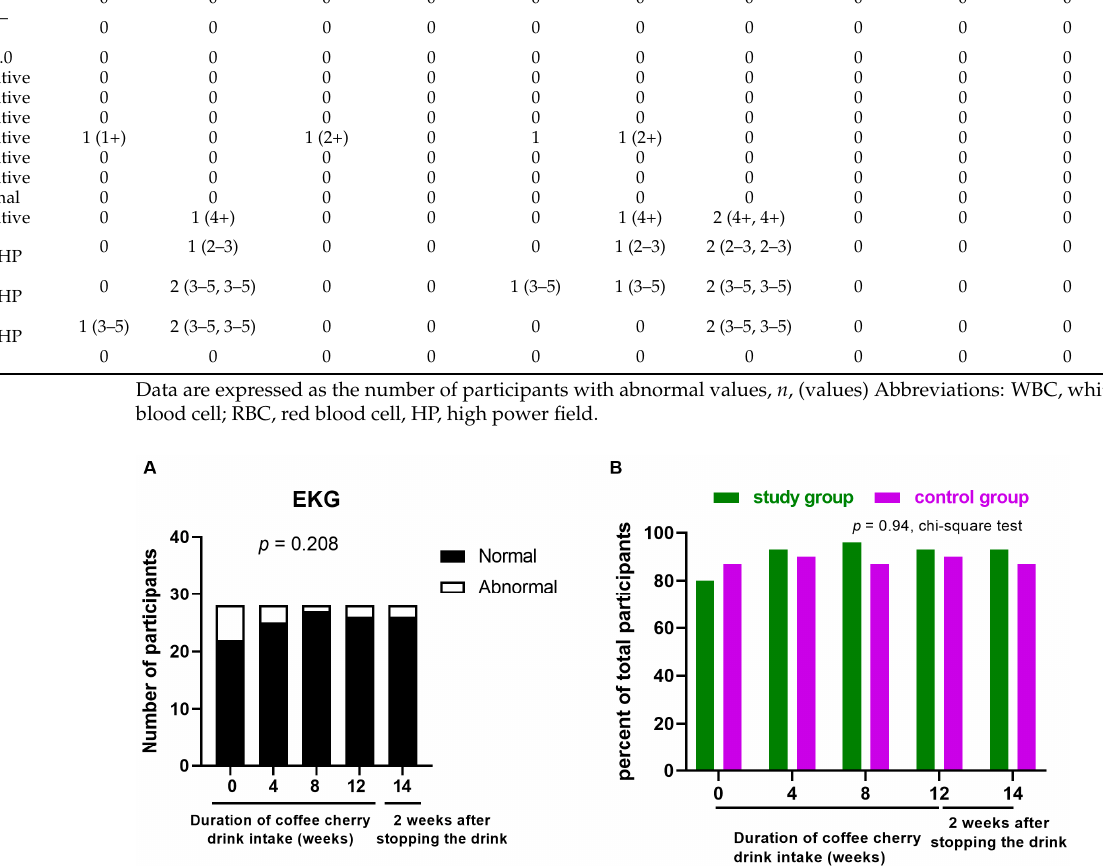
Figure 10. Changes in EKG. The stacked bar graph shows the number of participants with normal (black bars) and abnormal (white bars) EKG characteristics after the cherry coffee concentrate intake for the specified period and 2 weeks after stopping intake (14 weeks) ( A ), with p -value obtained from chi-squared test; the bar graph shows the percentage of participants with normal EKG characteristics in the study (green) and control (purple) groups ( B